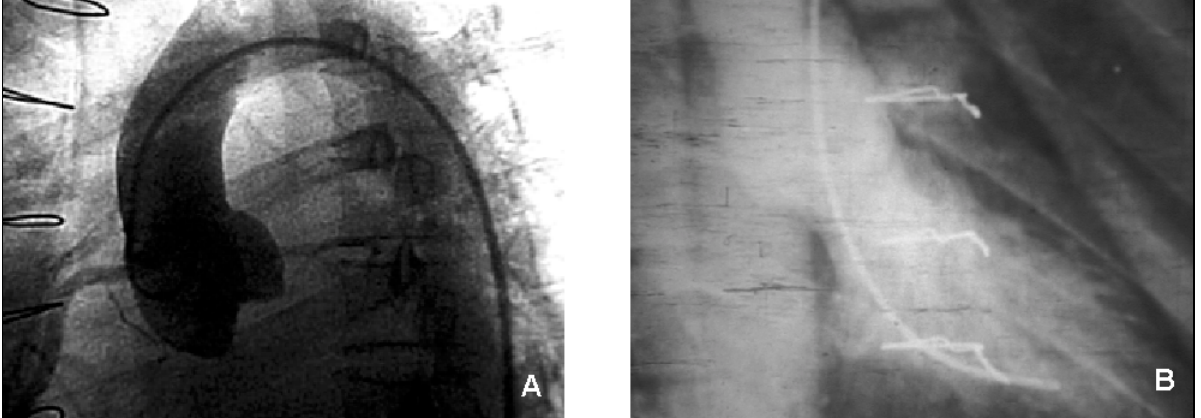
Fig. 4 – A- Aortografia pós-operatória. A- imagem angiográfica é similar a valva aórtica normal. B- Ventriculografia esquerda pós-operatória. Notar a ausência de qualquer grau de obstrução